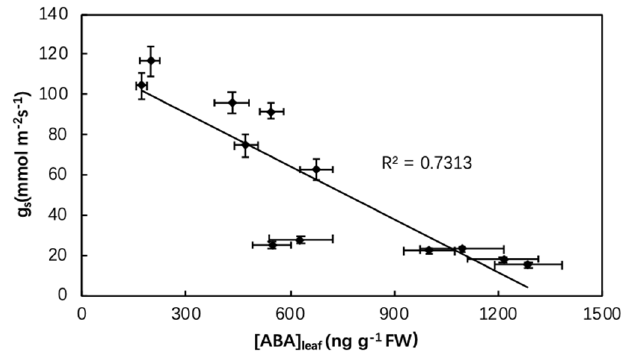
Figure 5. Relationship between stomatal conductance (g s ) and abscisic acid (ABA) concentrations of quinoa leaves as affected by biochar, irrigation regimes, and salinity.